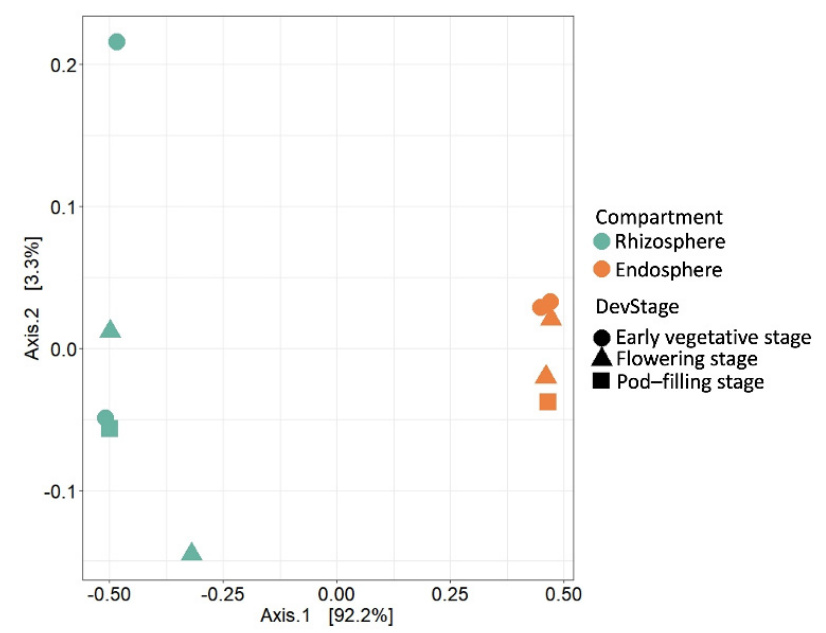
Figure 2. Community structure of the root microbiome of field-grown common bean ( P. vulgaris ) at three ontogenetic stages. Principal Coordinate Analysis (PCoA) of 16S rRNA diversity of rhizosphere (green-cyan) and endosphere (orange) samples taken at the three developmental stages (DevStage) indicated by symbol forms as early vegetative (circles), flowering (triangle) or pod-filling stage (squares). For each compartment, n = 2 biologically independent samples for the vegetative and flowering stage and n = 1 for the pod-filling stage).